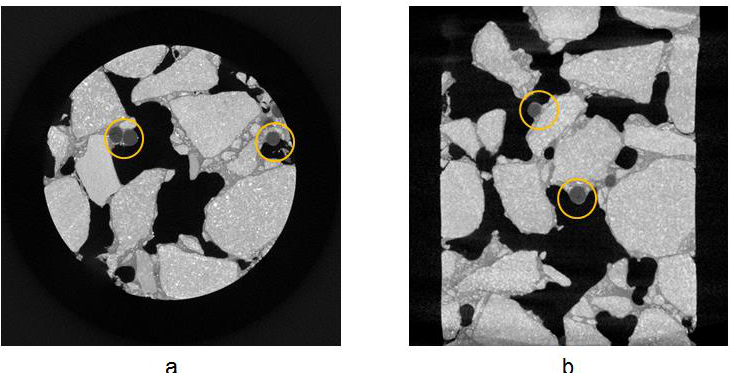
Figure 7. X-ray tomography images: ( a ) top view of the porous asphalt cylinder and ( b ) front view of porous asphalt cylinder.